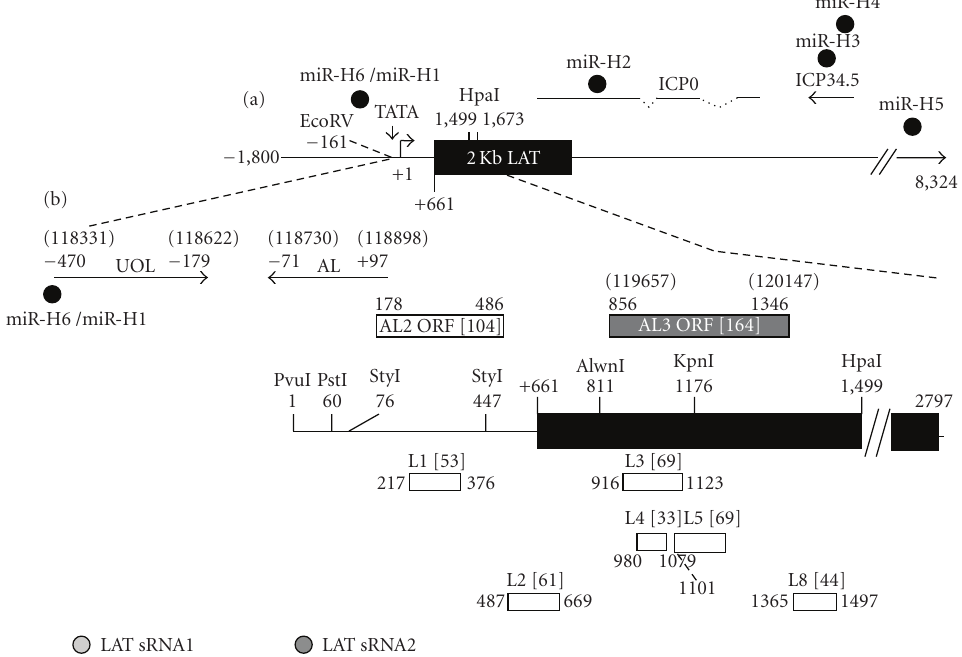
Figure 3: Schematic of factors encoded within the LAT locus. (a) Schematic of genes within the long repeats that contain the LAT locus. The large arrow indicates the primary LAT transcript. The solid rectangle represents the very stable 2kb LAT intron. The start of LAT transcription is indicated by the arrow at +1 (genomic nucleotide 118801). Several restriction enzyme sites and the relative locations of the ICP0 and ICP34.5 transcripts are shown for reference. The locations of the 6 micro-RNAs (miR-H1-6) that are located within the 8.3kb LAT [136] are shown. (b) Partial restriction map of LAT and position of LAT open reading frames (L1-8) within the first 1.5 Kb of strain McKrae LAT coding sequences, which were based on previous studies [137]. The numbering system of the ORFs was consistent with a previous study [137]. Only the ORFs with at least 30 amino acids are shown (the number of amino acids in each ORF is denoted by the numbers in brackets). Open circles denote the position of two LAT small RNAs that are encoded within the first 1.5 kb LAT coding sequences [138]. Positions of UOL transcript, AL transcript, and ORFs located on the opposite strand of LAT (AL2 and AL3) are shown. The numbers of amino acids of AL2 and AL3 are in brackets. Nucleotide positions relative to the start of LAT transcription are not shown in parenthesis. Numbers in parentheses represent HSV-1 nucleotide